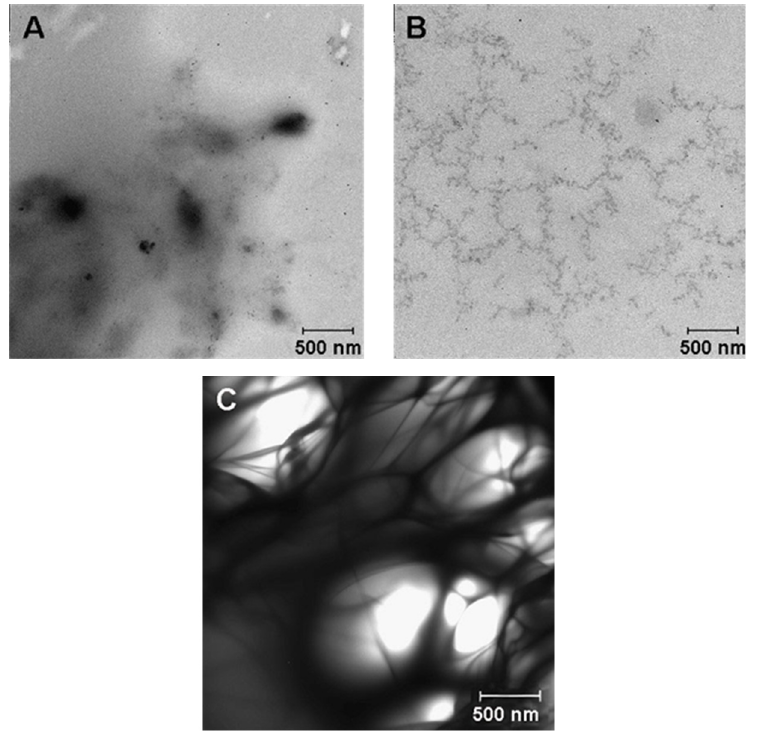
Figure 2. TEM images of Tween 20 ( A ), PEG-2000 ( B ), and the mixture of Tween 20 and PEG-2000 ( C ).